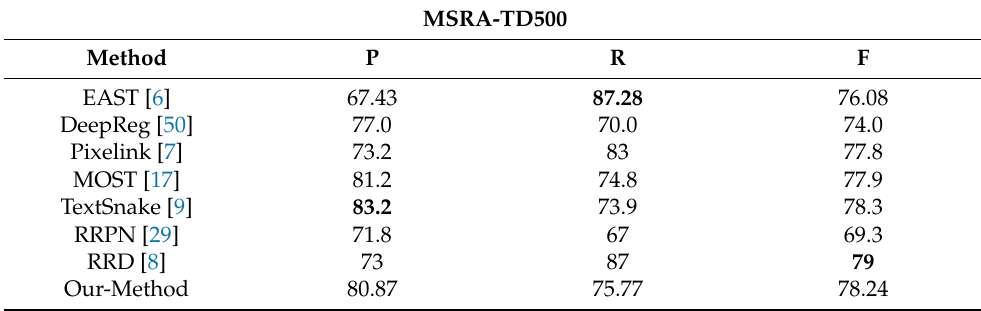
Table 5. The single-scale results on MSRA-TD500. “P”, “R”, and “F” represent the precision, recall, and F-measure, respectively. The best results of all measures are